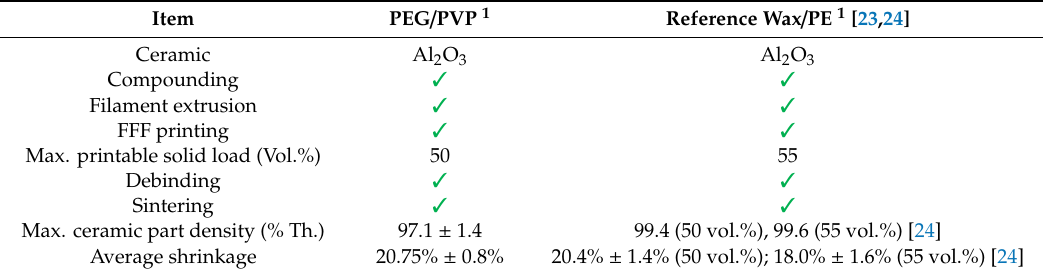
Table 4. Comparison two di ff erent feedstocks: overall process chain